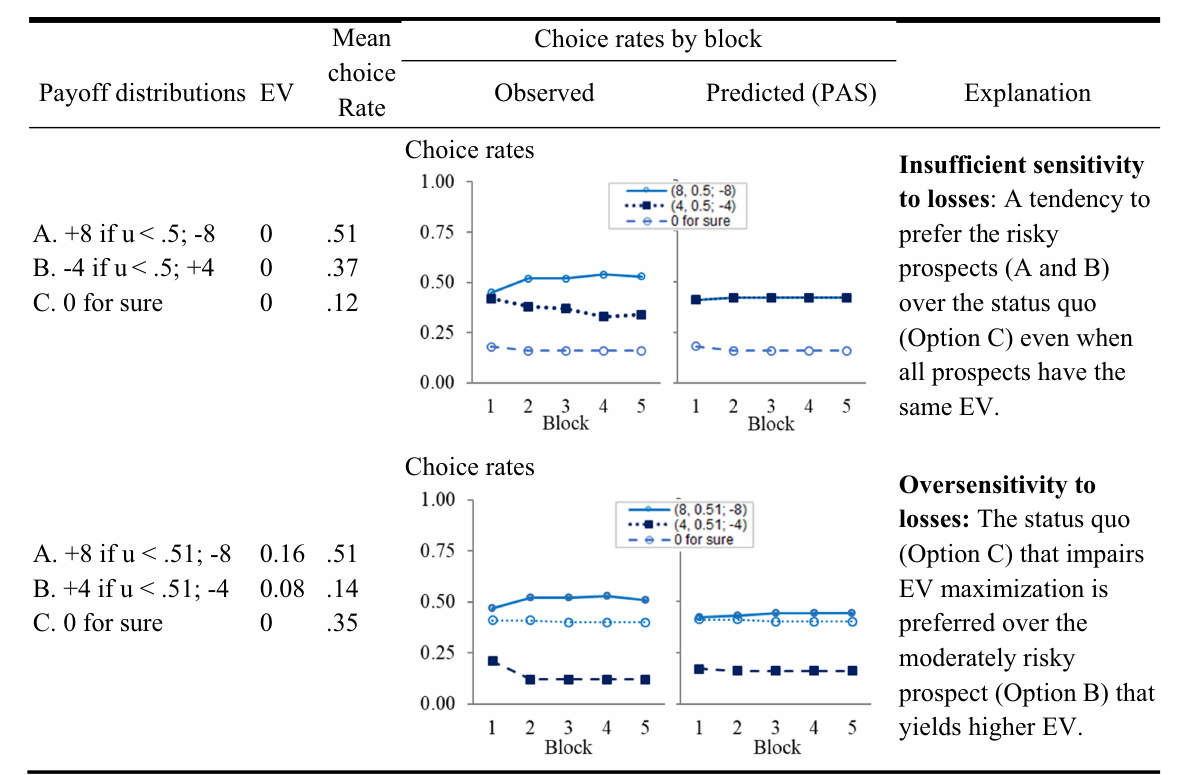
FIGURE 4 The impact of experience on sensitivity to losses (from Erev et al., 2023). The experiment used a variant of the experimental paradigm described in the lower panel of Figure 1. It included 100 trials, and the participants were presented with the payoff from all options after each choice. The left- hand column presents the incentive structure, u is a random draw from the range 0 to 1 [that is, from u(0,1)]. The right-hand choice rate graphs present the prediction of the PAS model, described